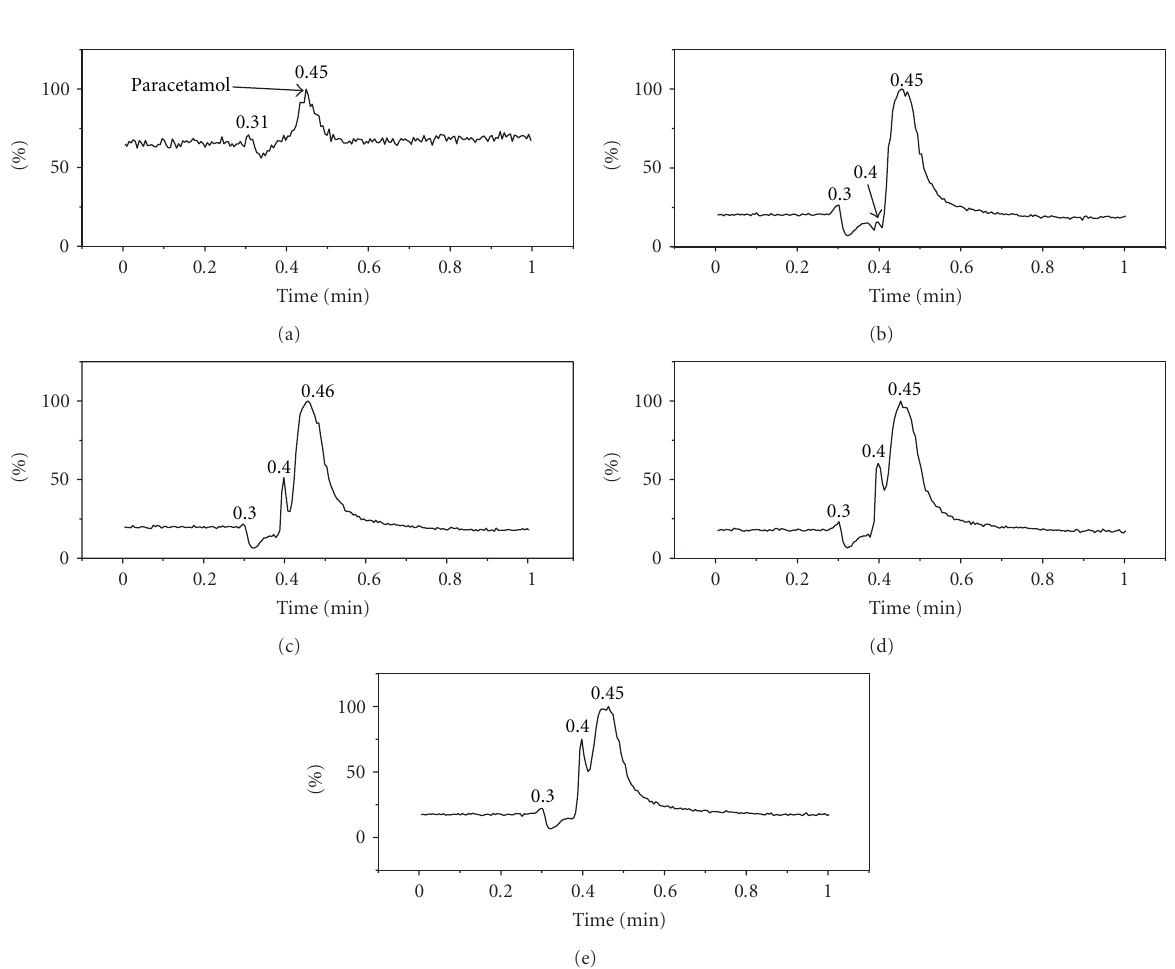
Figure 7: UPLC chromatograms obtained for (a) a standard solution of 0.1mgmL − 1 paracetamol, and for samples collected from the electrochemical reactor at (b) 0, (c) 30, (d) 60, and (e) 90 minutes.